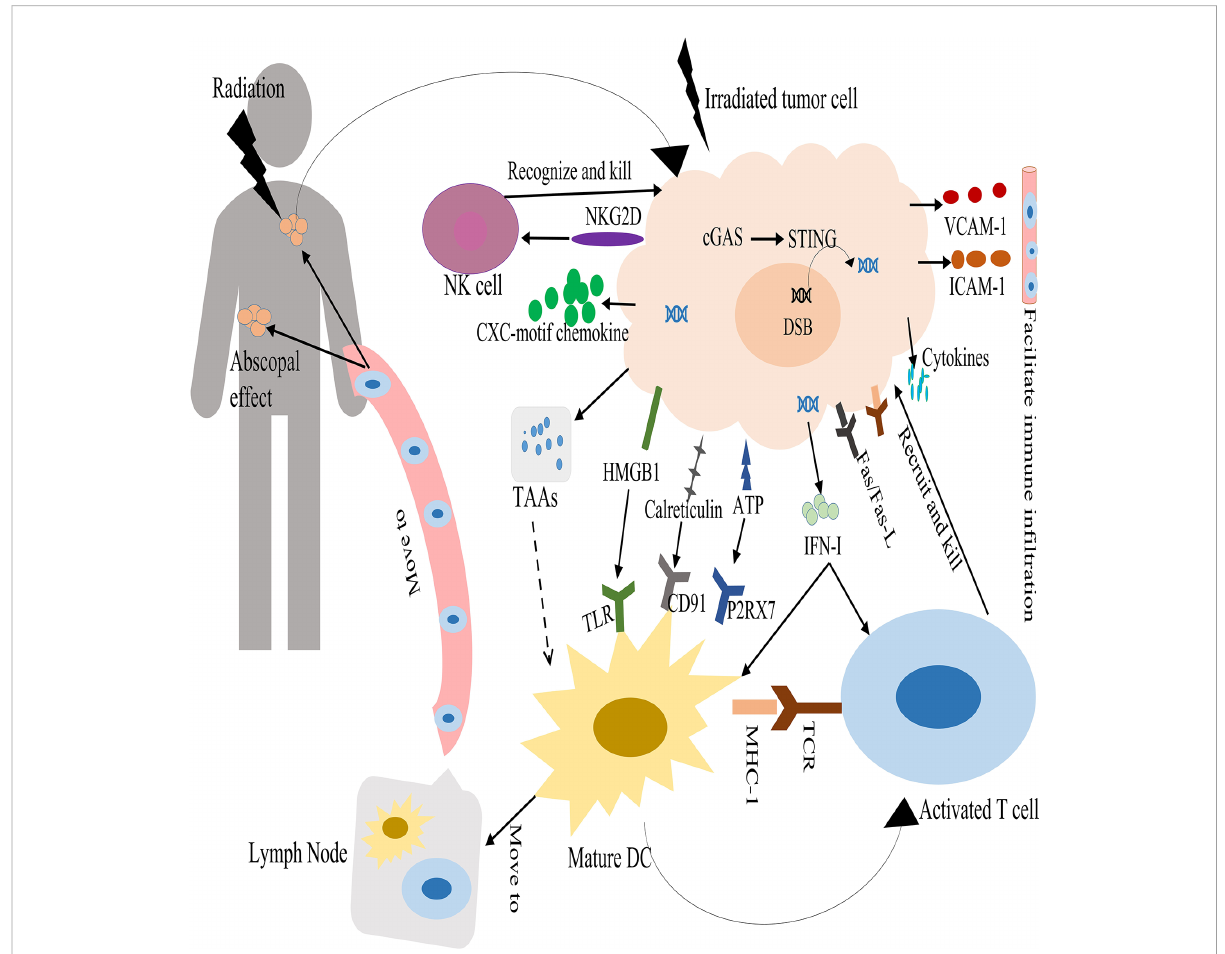
FIGURE 1 Antitumor immune enhancement of radiotherapy. Radiation therapy causes DNA DSBs in tumor cells and is sensed by the cGAS – STING pathway, resulting in the production of interferon I (IFN-I). In turn, IFN-I can stimulate dendritic cells (DCs) and T cell activation. Radiation therapy can induce immunogenic cell death. This releases danger-associated molecular patterns that promotes the activation and maturation of dendritic cells. DCs take up tumor-associated antigens (TAAs) from damaged tumor cells and travel to draining lymph nodes, and then present the TAAs on major histocompatibility complex class I (MHCI) to T cells through the T-cell receptor (TCR). Activated T cells move to the irradiated tumor and non-irradiated tumors through the blood circulation. Radiation can upregulate Fas and MHC-I molecules expression on tumors, and increase the release of cytokines and chemokines by tumor cells. This promotes the recruitment of activated T cells to kill tumor cells. In addition, radiation can upregulate the NK pathway to mediate tumor cells